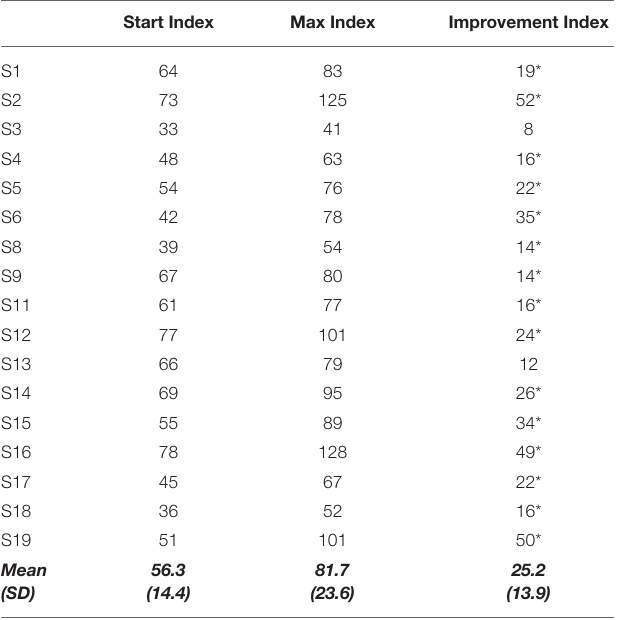
TABLE 2 | CogMed working Memory